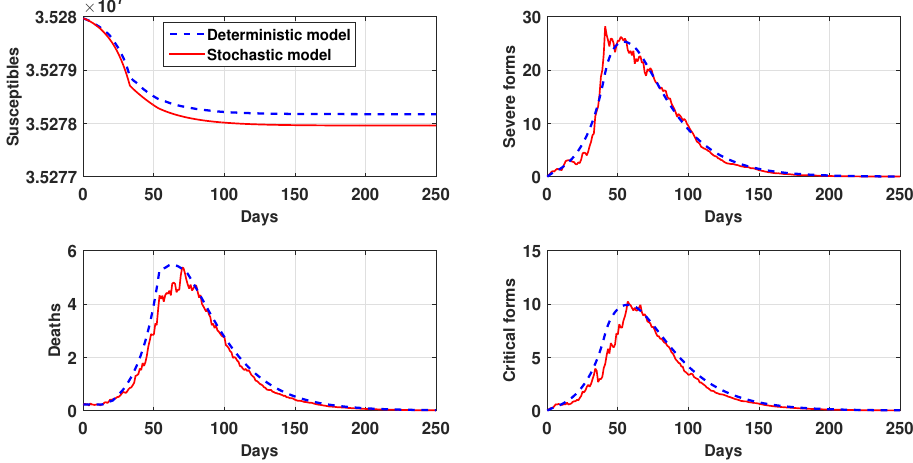
Figure 3. The evolution of susceptible, deaths, severe and critical forms from March 02, 2020.